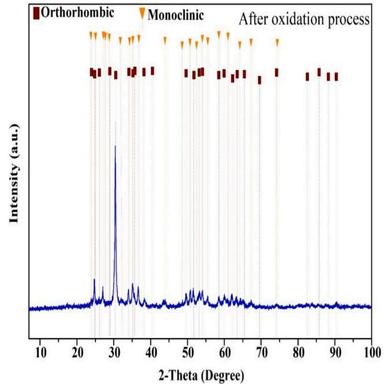
XRD spectra of produced HEOs after oxidation.